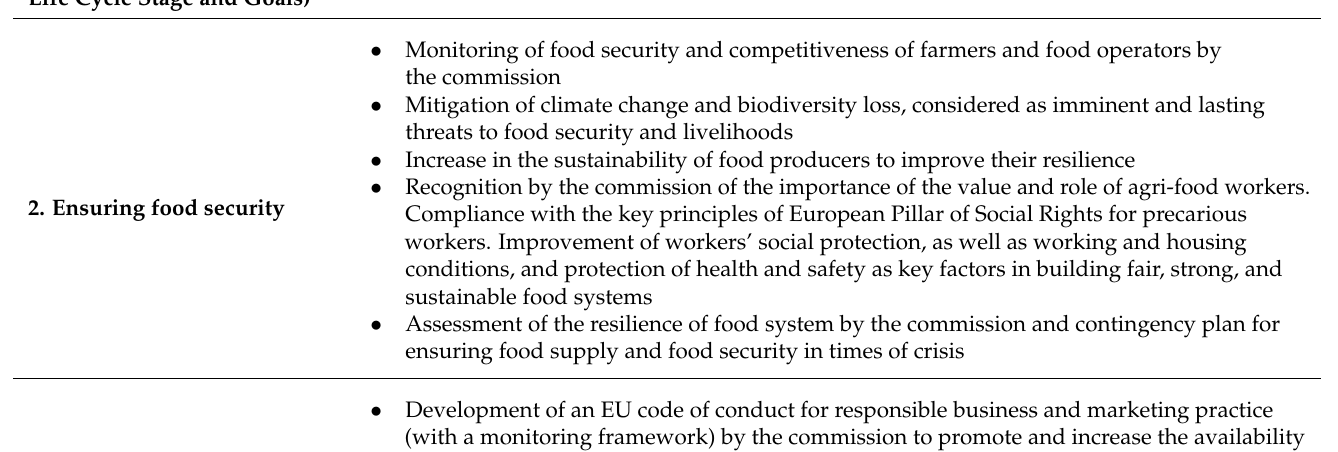
Areas of Intervention (Food Life Cycle Stage and